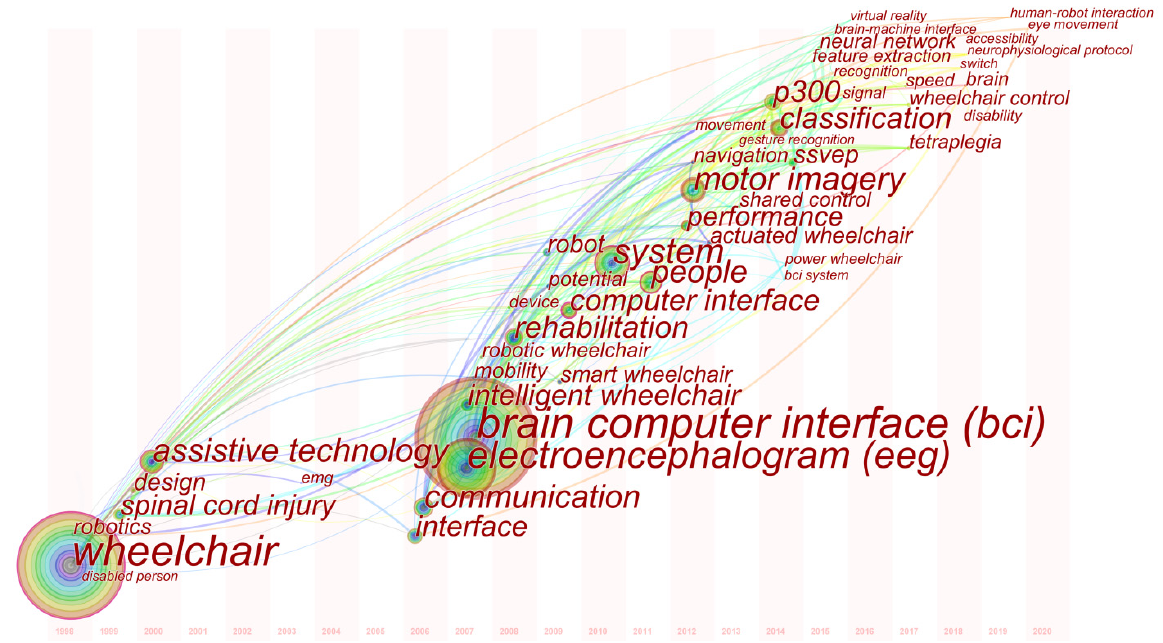
Figure 9. Keyword co-occurrence time zone map for EPW HMI methodology research.